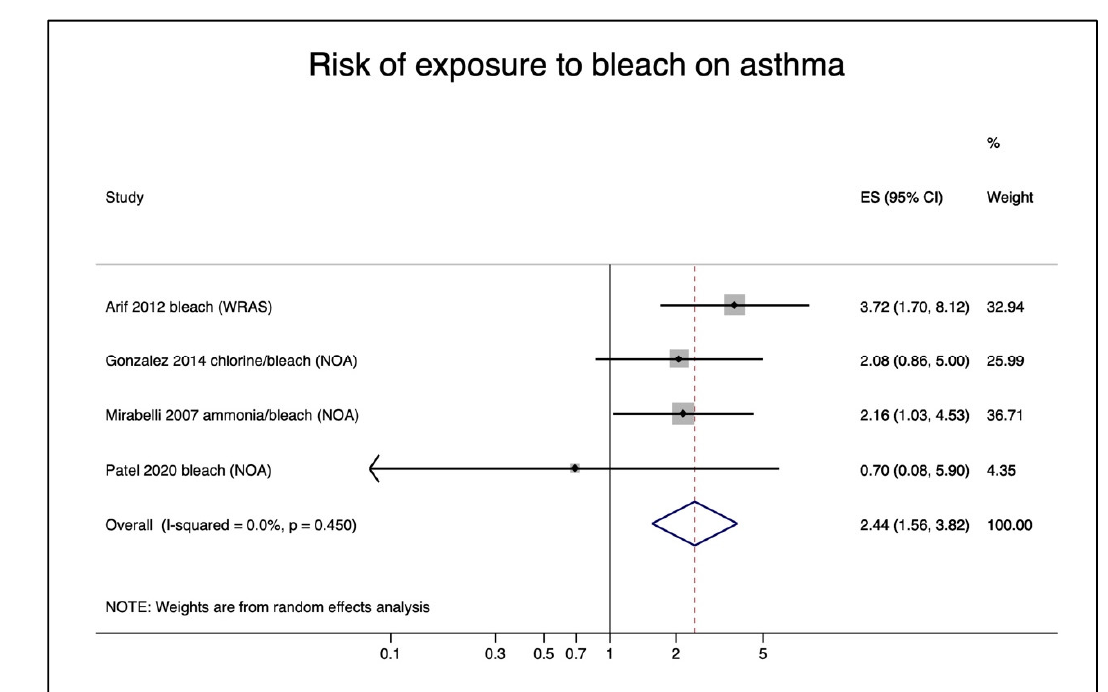
Figure 5. Pooled risk of cleaning/disinfecting/sterilization of instruments and medical equipment on new-onset asthma in nurses.